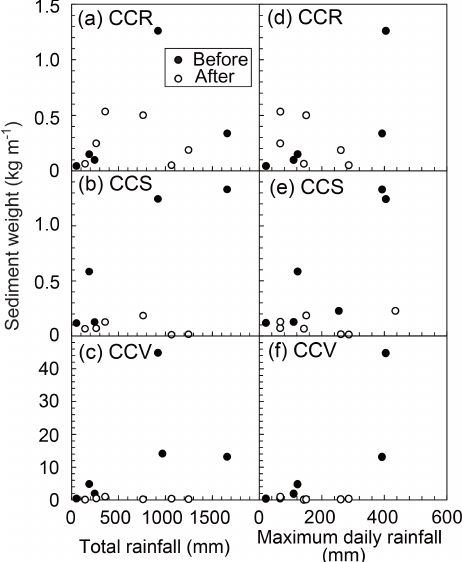
Figure 13. Comparison between rainfall factors and sediment weight captured by sediment traps during rainfall seasons in the harvested area. (a) Total rainfall and sediment weight at plot CCR. (b) Total rainfall and sediment weight at plot CCS. (c) To- tal rainfall and sediment weight at plot CCV. (d) Maximum daily rainfall and sediment weight at plot CCR. (e) Maximum daily rain- fall and sediment weight at plot CCS. (f) Maximum daily rainfall and sediment weight at plot